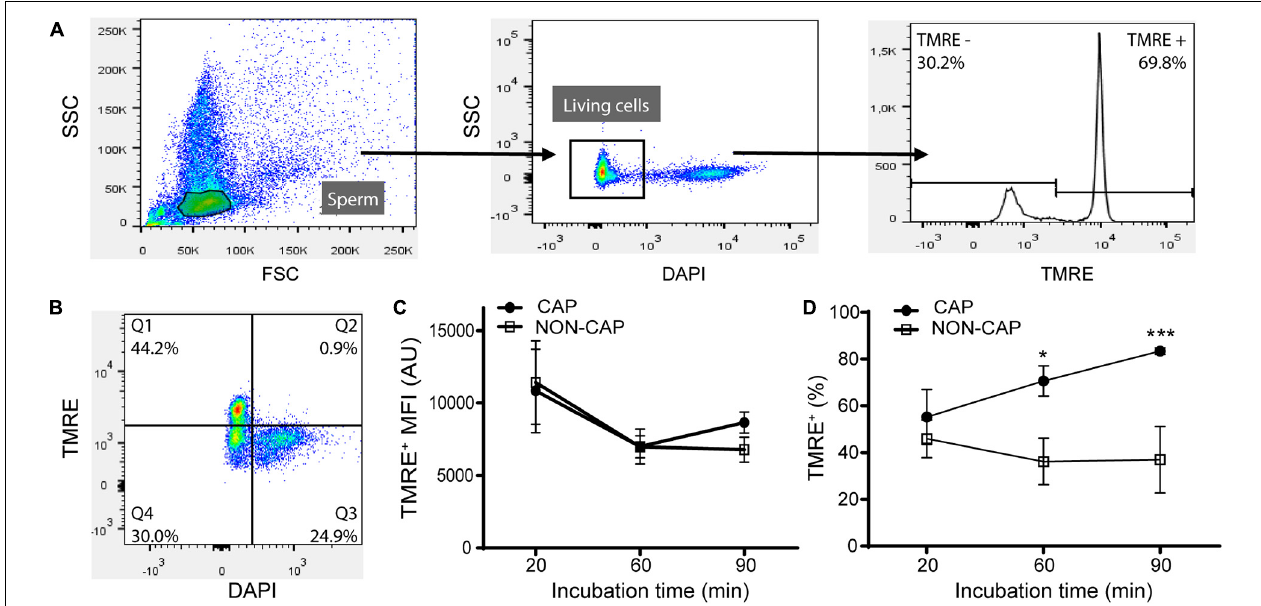
FIGURE 1 | Determination of mitochondrial membrane potential by flow cytometry during mouse sperm capacitation. Epididymal mouse sperm were incubated under non-capacitating or capacitating conditions, loaded with TMRE, and fluorescence was measured by flow cytometry. (A) Gating strategy used in the analysis: sperm were selected on a forward (FSC) and side scatter (SSC) plot (left panel) and, then, DAPI negative (living) cells (center panel) were further gated to determine the percentage of TMRE+ and TMRE − cells (right panel). Representative data of capacitated sperm is shown. (B) A representative image of a TMRE and DAPI scatter plot showing that only living cells present TMRE staining (Q1). (C) Mean fluorescence intensity (MFI) from capacitated (CAP) and non-capacitated (NON-CAP) TMRE + sperm at different incubation times. (D) Percentage of CAP and NON-CAP TMRE + sperm at different incubation times. Results are expressed as mean ± SEM. n = 5. * p < 0.05, *** p <